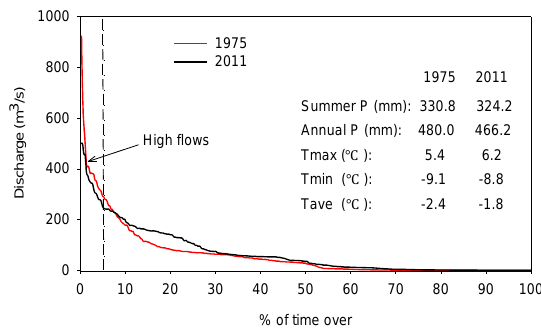
Figure 4. Flow duration curves for the paired years of 1975 and 2011 in the UHR watershed.